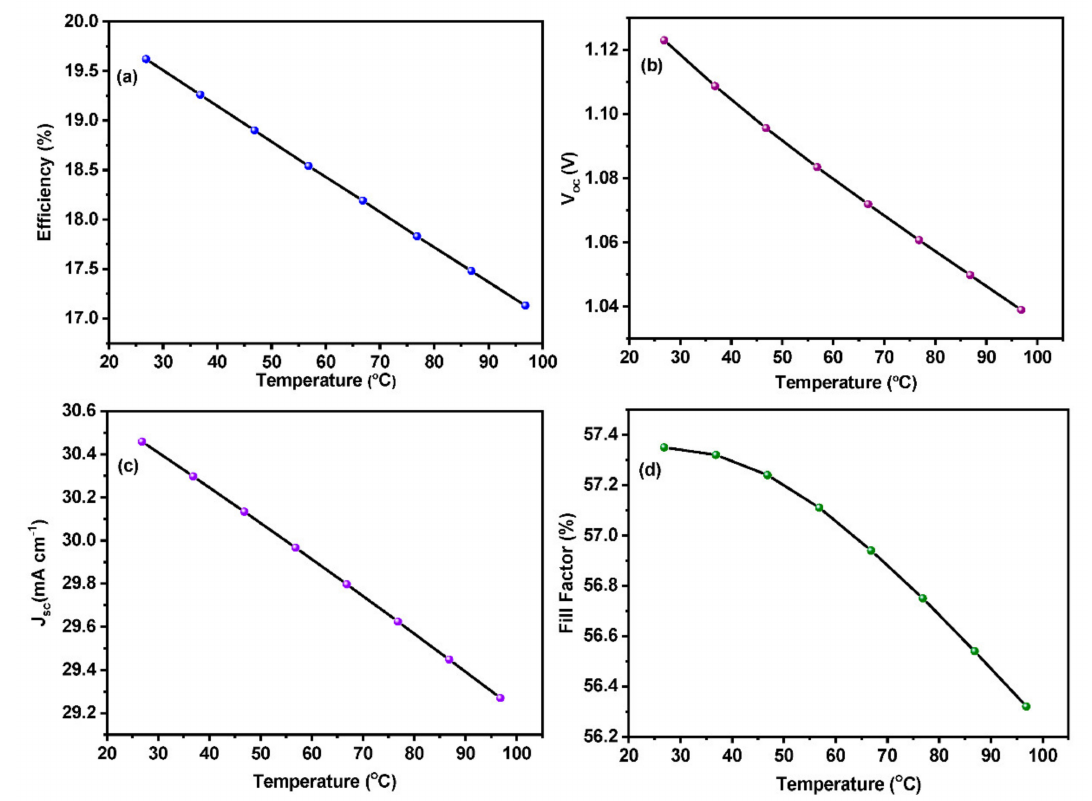
Figure 6. Effect of device temperature on ( a ) efficiency, ( b ) V oc ( c ) J sc and ( d ) Fill